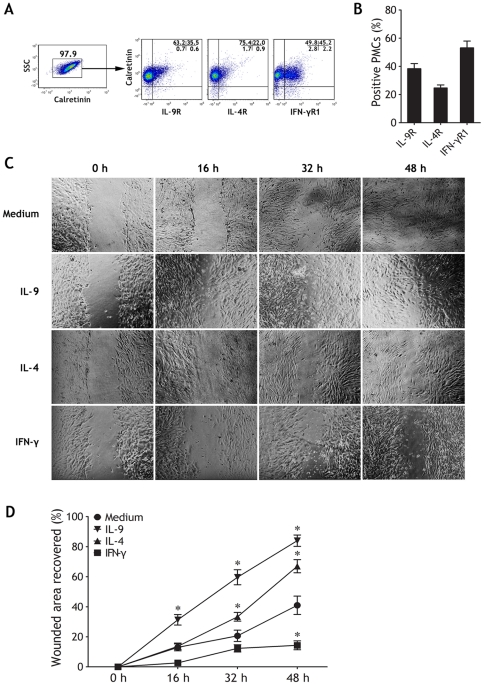
Effects of IL-9, IL-4 and IFN-γ on wound healing of in vitro injury model of pleural mesothelial cells.(A) Pleural mesothelial cells was identified by expression of calretinin and sideward scatter (SSC) using flow cytometry, the representative flow cytometric dot-plots are showing expression of IL-9R, IL-4R, and IFN-γR1 on PMCs from tuberculous pleural effusion. (B) Summary dada of percentages of IL-9R+, IL-4R+, and IFN-γR1+ PMCs (n = 5). (C) Microscopic photography after wound induction on a confluent monolayer of PMCs in a time course from 16 to 48 h revealed that wound healing was enhanced by IL-9 or IL-4 and retarded by IFN-γ (Original magnification: ×200). (D) Graphs show relative wound closure over time, based on the wound gap compared with initial wound size. Mean ± SEM of 5 independent experiments. The comparisons were determined by Kruskal-Wallis one-way analysis of variance on ranks, *p<0.05 compared with medium control at the same time points.